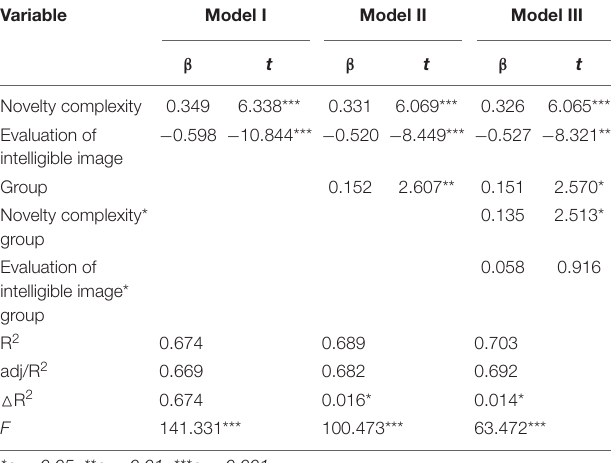
TABLE 10 | Moderating effects of novelty–complexity, intelligible image evaluation, and interest.